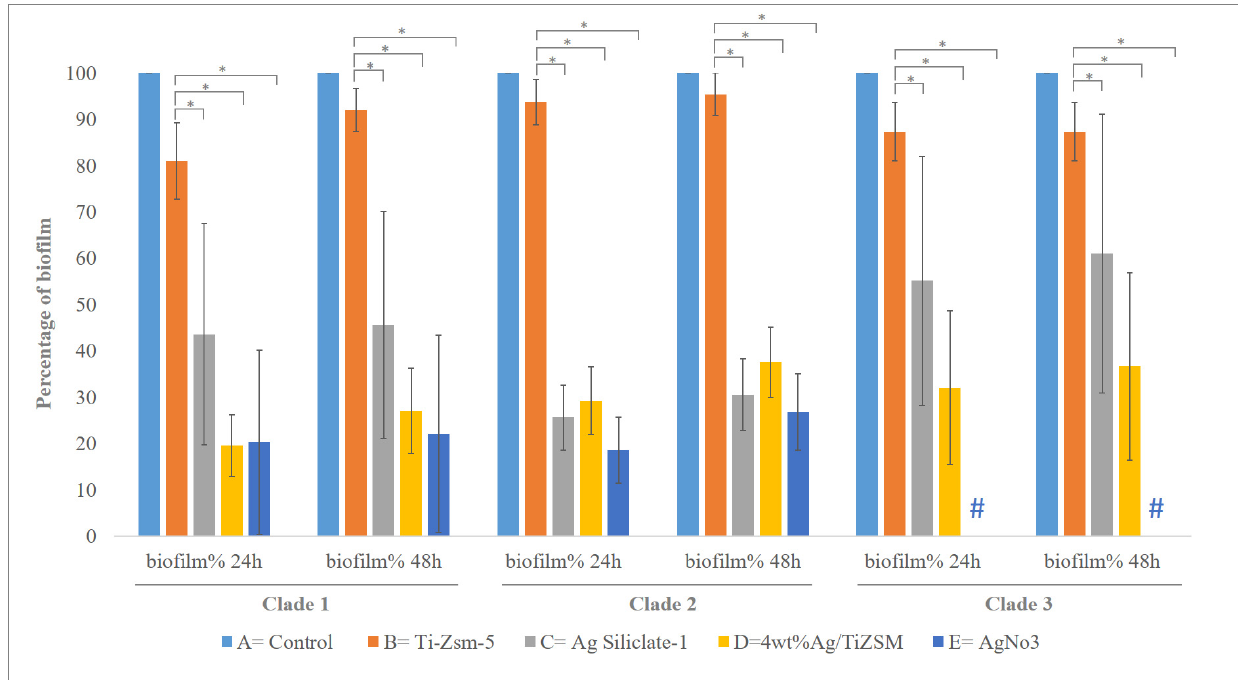
Figure 9. Graph showing the effect of synthesized nanomaterial on the formation of biofilm of 3 clades of C. auris strains after 24 and 48 h incubation period. # Complete absence of biofilm. * p < 0.01.